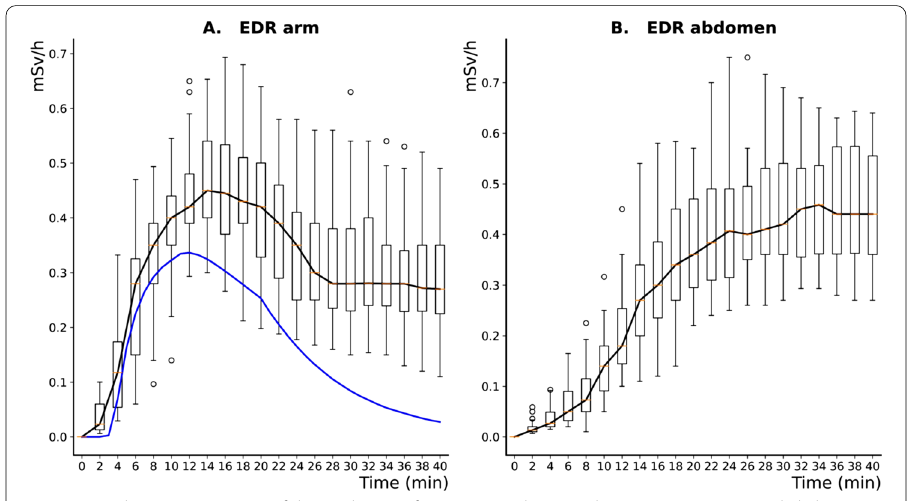
Fig. 5 Box-plot representation of the evolution of experimental EDR at the patients’ arm ( A ) and abdomen ( B ) for the 33 Lutathera-based PRRT infusion procedures with the associated median value for each time point (black curve). The evolution of simulated EDR at the patient’s arm with the proposed infusion modeling is also depicted ( A , blue